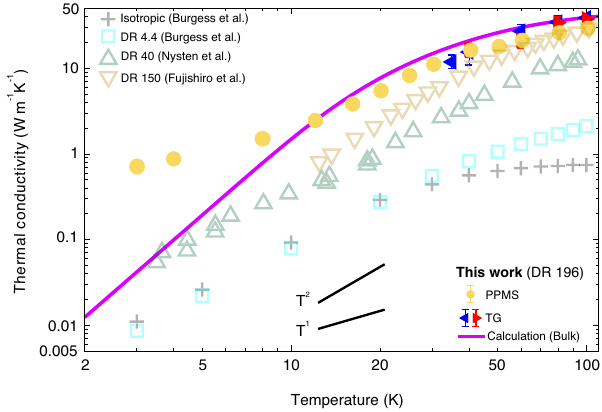
Fig. 3 Cryogenic bulk thermal conductivity versus temperature below 100 K. Measurements from this work (TG: fi lled colored triangles; PPMS: yellow circles) along with the predictions of an anisotropic Debye model (purple solid line) are shown. Representative literature data for semi- crystalline PE with various DRs are also plotted as open symbols (extruded thin fi lm, DR 4.4, ref. 8 ; solution-cast thin fi lm, DR 40, ref. 73 ; solution-cast macroscopic fi ber, DR 150, in ref. 80 ). As temperature decreases, the trend of measured thermal conductivity exhibits a transition from ∼ T 2 to ∼ T near 10